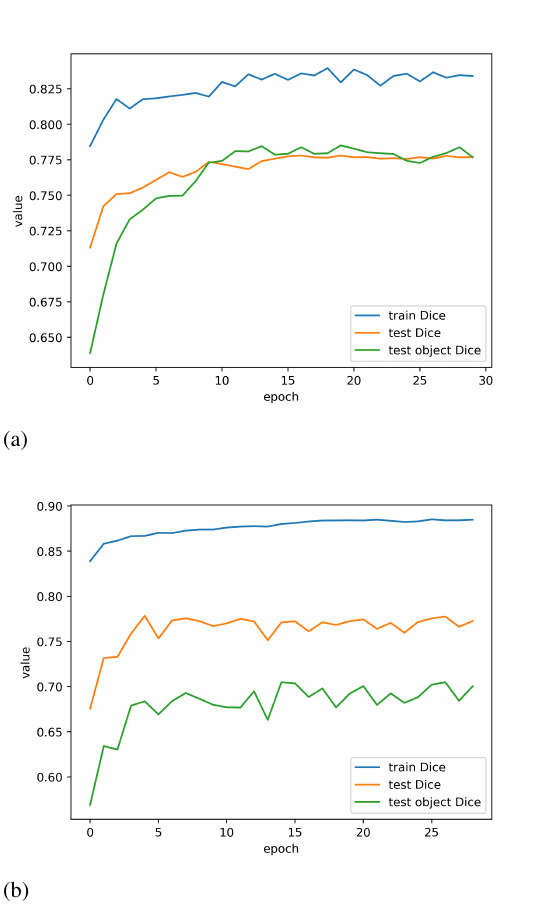
Figure 9. Dice and object Dice scores while training the proposed CNN on PATH-DT-MSU dataset (a) with normal gland annotations only and (b) with both normal and ”open” glands. where where S i denotes the i th segmented object, G i denotes a ground truth object that maximally overlaps S i , (cid:102) G j denotes the j th ground truth object, (cid:101) S j denotes a segmented object (cid:80) n S | S m | , (cid:101) ω j that maximally overlaps (cid:102) G j , ω i = | S i | / m =1